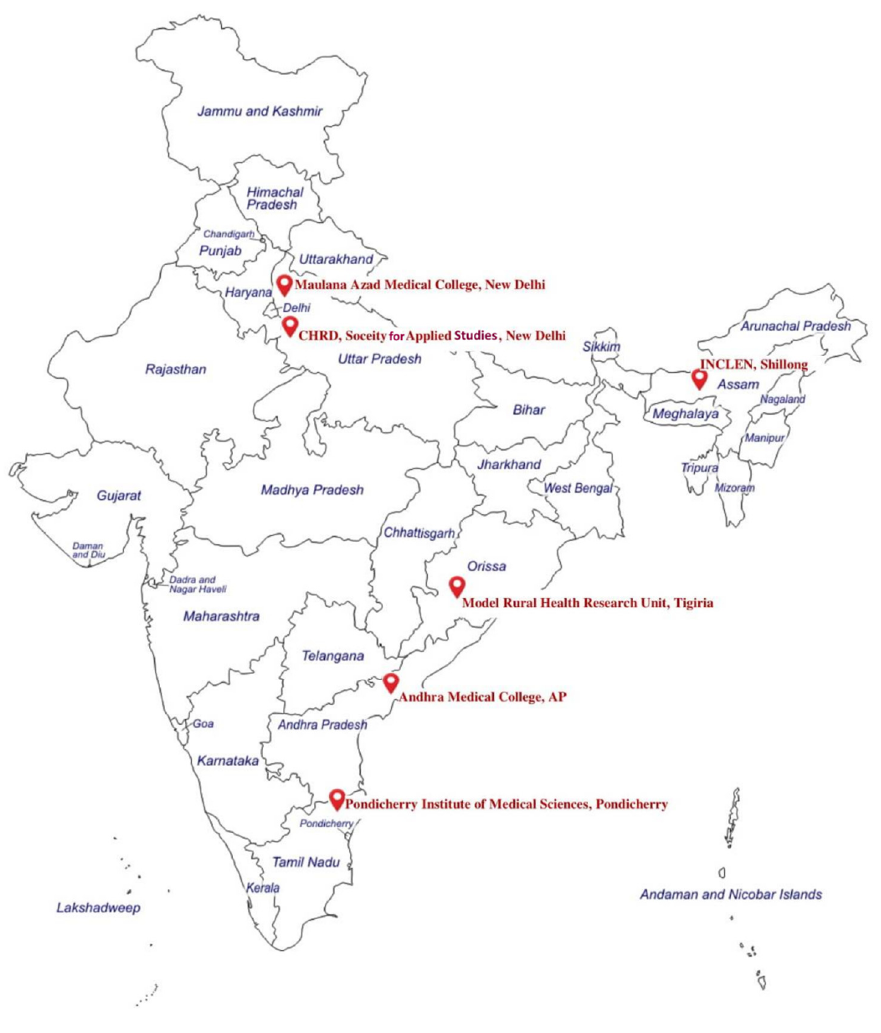
Figure 1. Locations of the planned Demographic Development and Environmental Surveillance System (DDESS) project sites in India.